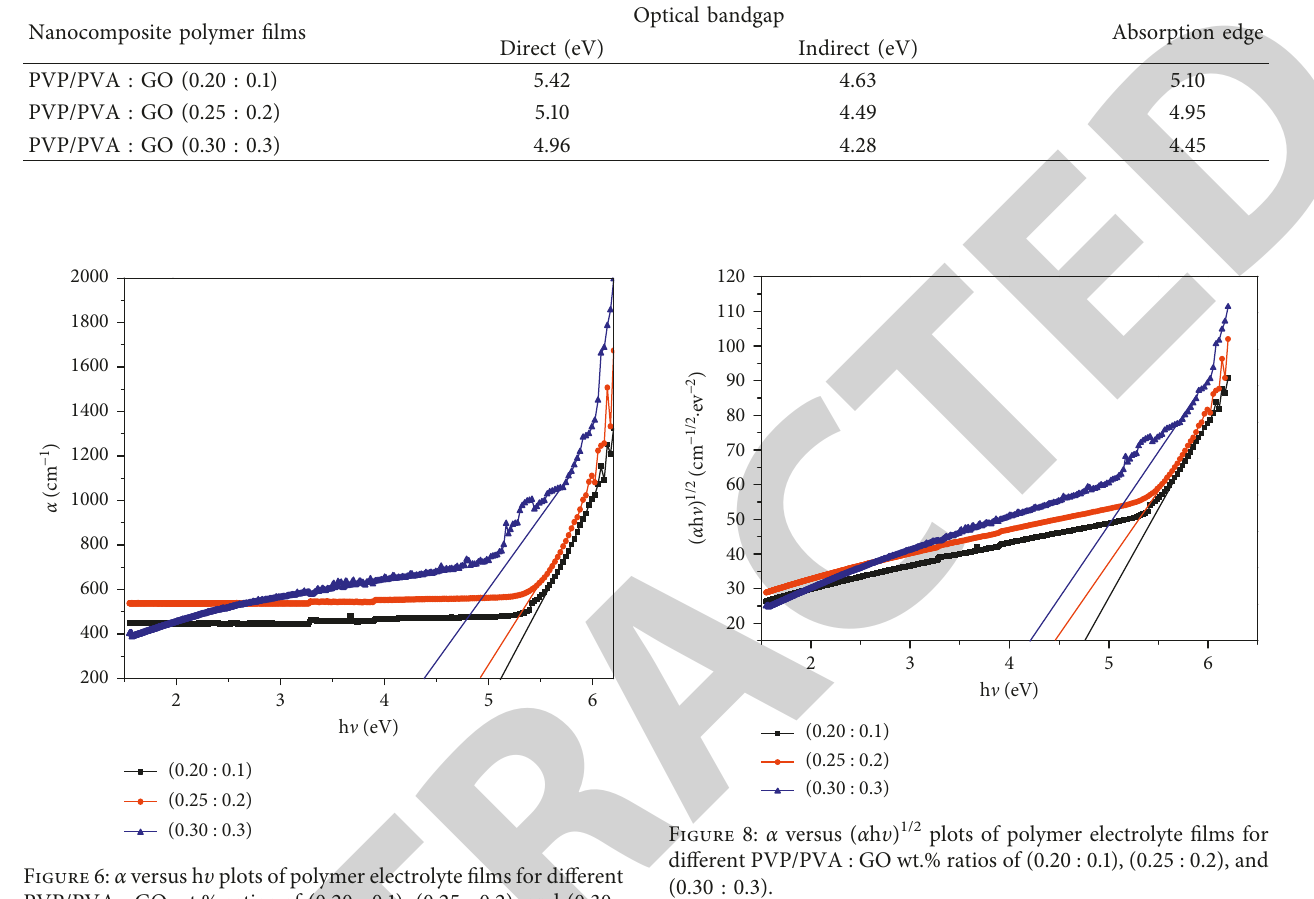
Figure 8: α versus ( α h υ ) 1/2 plots of polymer electrolyte films for different PVP/PVA : GO wt.% ratios of (0.20 : 0.1), (0.25 : 0.2), and (0.30 : 0.3).